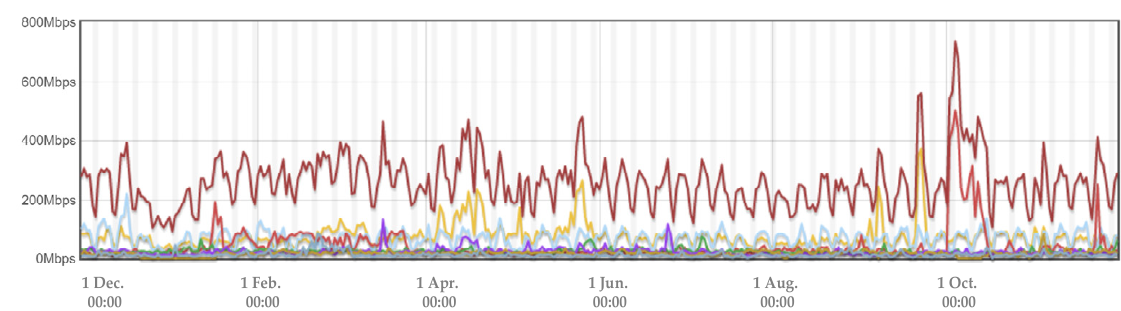
Figure 5. Flow diagram for BPS perspective in Agurim. Figure 5 . Flow diagram for BPS perspective in Agurim. Figure 5 . Flow diagram for BPS perspective in Agurim.